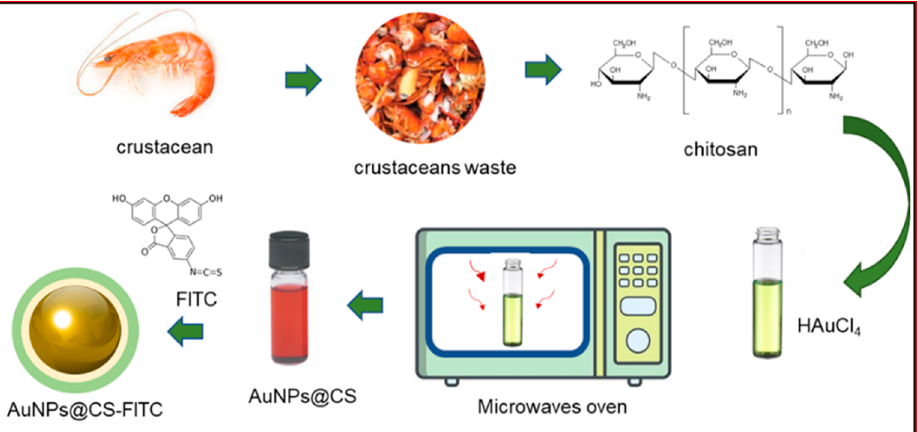
Figure 1. Schematic representation of AuNPs@CS-FITC achievement.